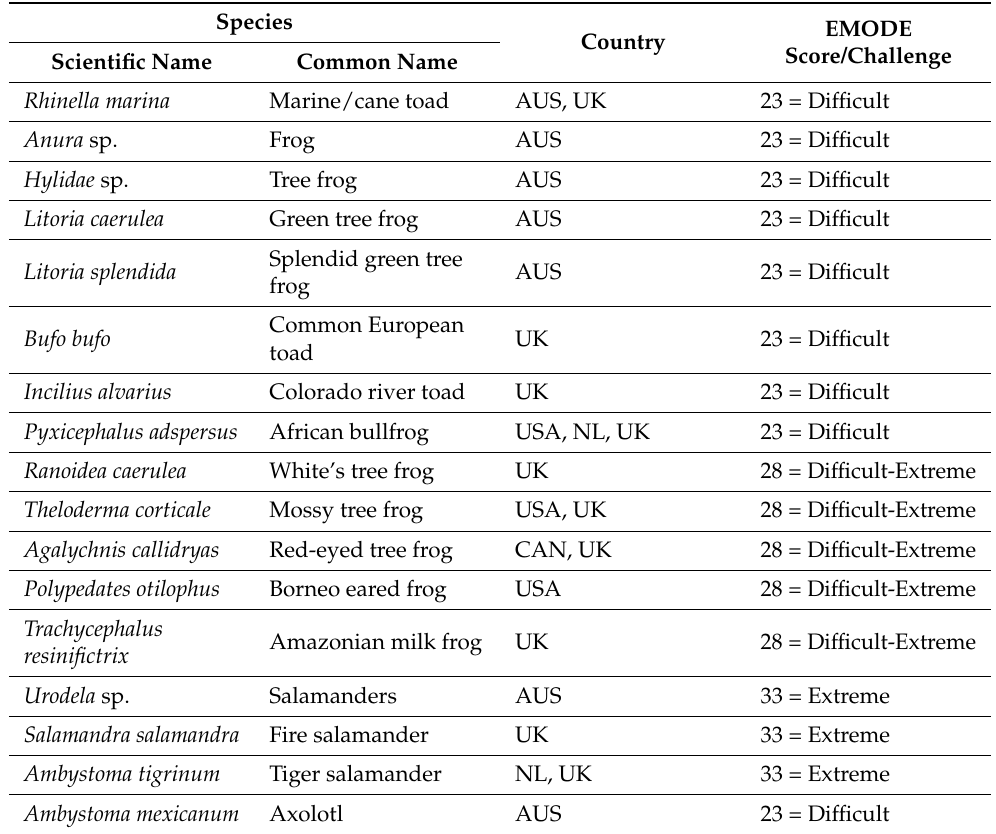
Table 5. Amphibians involved in handling and other practices at mobile zoos by species and country of where used, and their EMODE ‘suitability to keep’